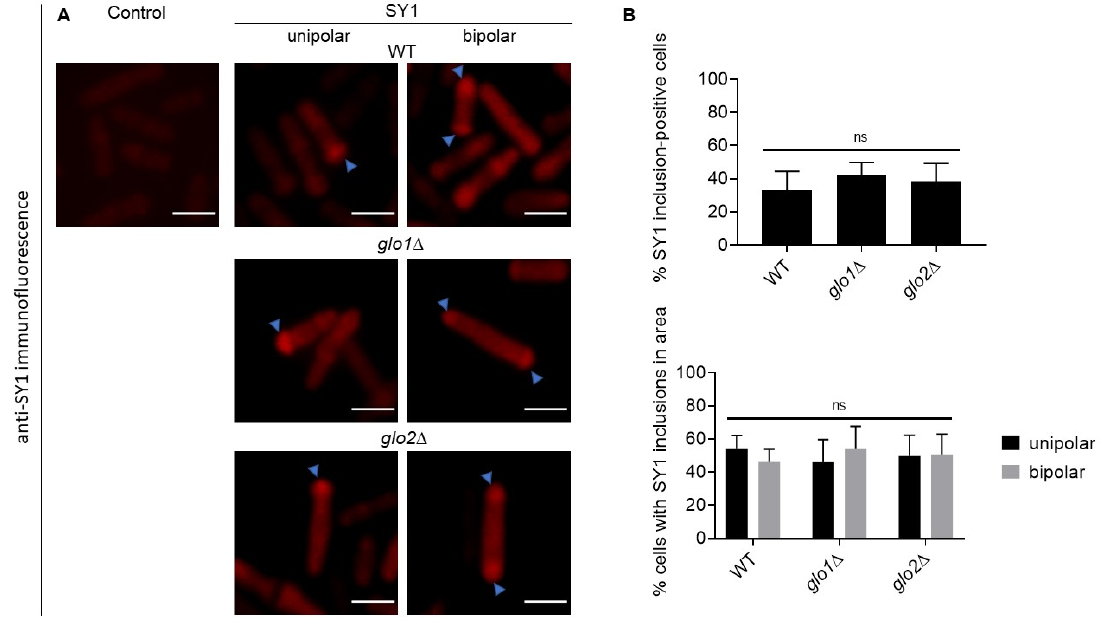
Figure 4. Analysis of the impact of a disrupted methylglyoxalase system on SY1 inclusion characteristics in wt, glo1 ∆ , and glo2 ∆ S. pombe strains. Native untagged SY1 was visualised via immunofluorescence microscopy using an anti-SY1 antibody ( A ), and the percentage of SY1-positive cells and the percentage of cells with unipolar or bipolar-localised inclusions were quantified ( B ). Significance is determined using a one or two-way ANOVA analysis ( p -value of 0.05). The scale bars represent 10 μ m. SY1 = Synphilin ‐ 1; ns = not significant.